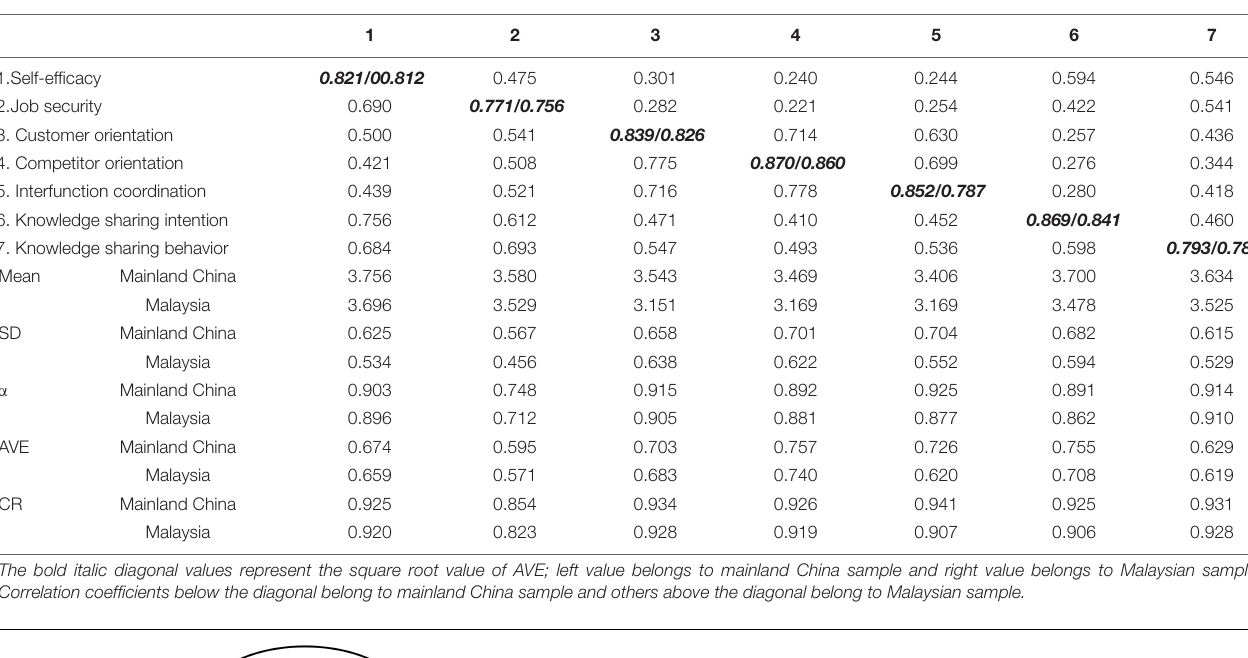
TABLE 1 | Measurement properties.